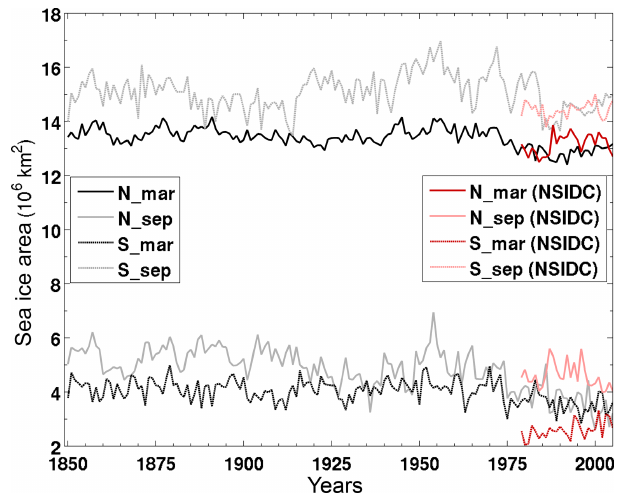
Figure 15. Modeled historical (black and grey lines) and observed (red lines) time series of sea ice area (10 6 km 2 ) in the Northern Hemisphere and Southern Hemisphere for September and March, respectively. Observations are from NSIDC (Fetterer et al., 2016).